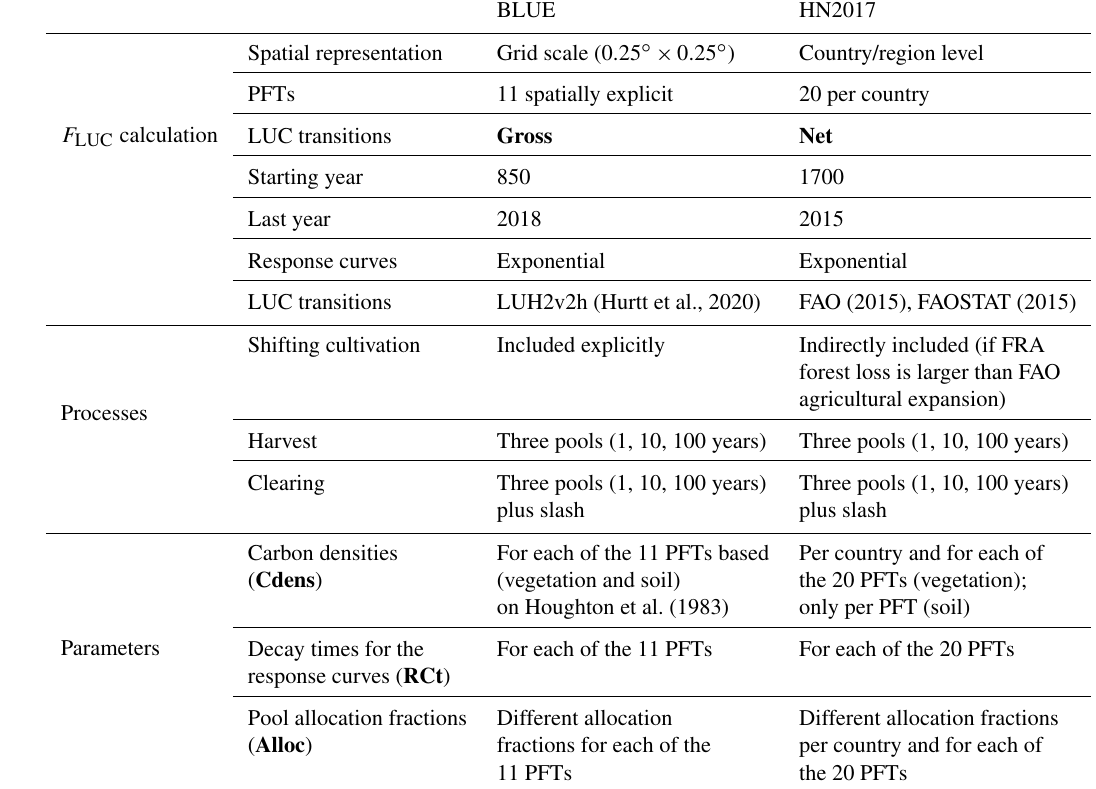
Table 1. Summary of the most important characteristics of the two F LUC estimates from the two BK models used in the GCB2019 (BLUE and HN2017), including how F LUC is calculated in the standard version and configuration of each model, the processes represented and how they are parameterised. The model assumptions and parameterisations investigated in this study (see Table 2) are highlighted in bold.